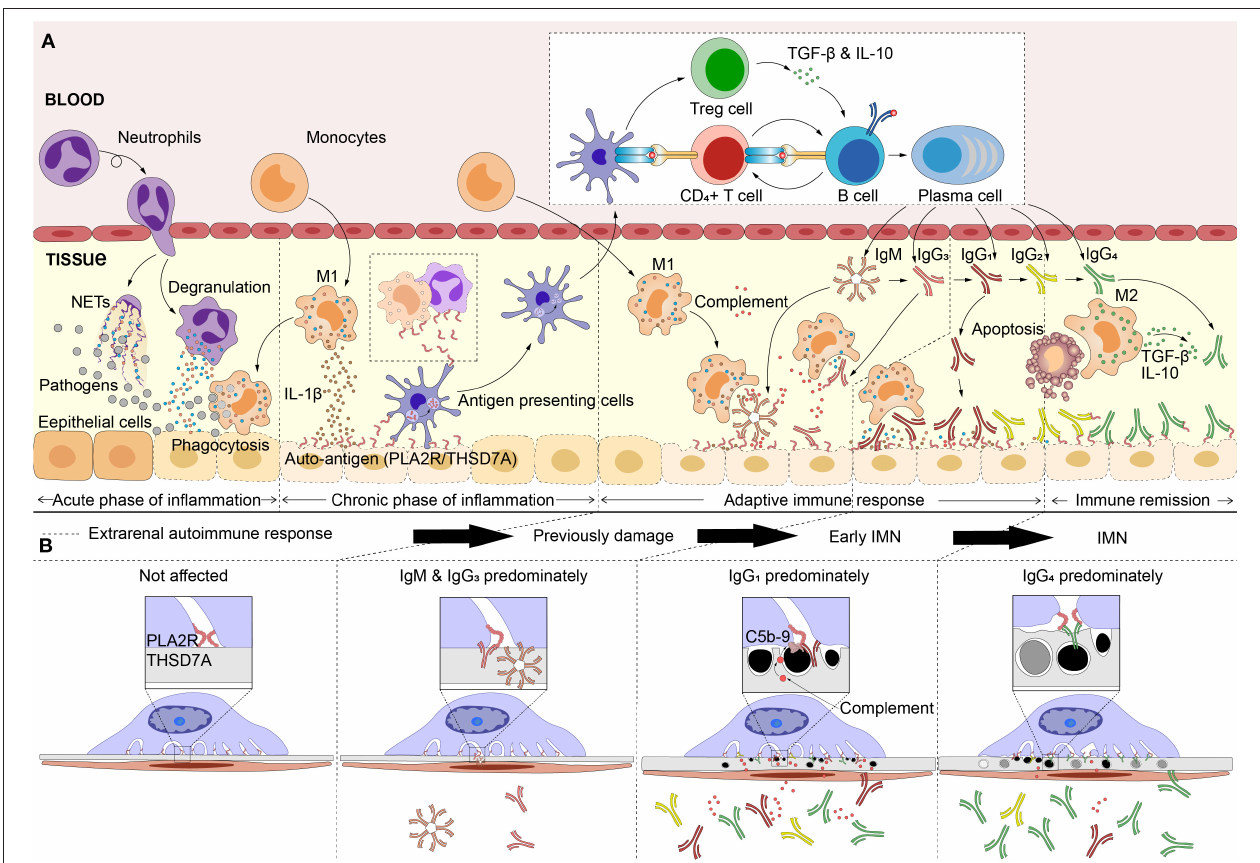
FIGURE 2 | Hypothetical pathogenesis model of idiopathic membranous nephropathy. (A) The pathogens (inhalable particles, bacteria and virus, etc) or other causes that affects the extrarenal tissues inducing inflammatory response. As the stimulus continues, the inflammation gradually goes in the phase that is dominated by M1 macrophages (encourage inflammation), and causes tissue damage (bystander damage). Hence, the auto-antigens such as M-type receptor for secretory phospholipase A2 (PLA2R1) or thrombospondin type-1 domain-containing 7A (THSD7A), are exposed in extrarenal inflammatory microenvironment. Pathogens